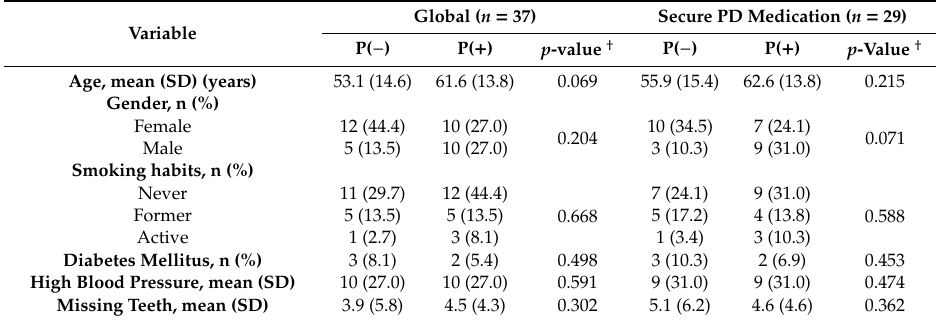
Table 1. Participants